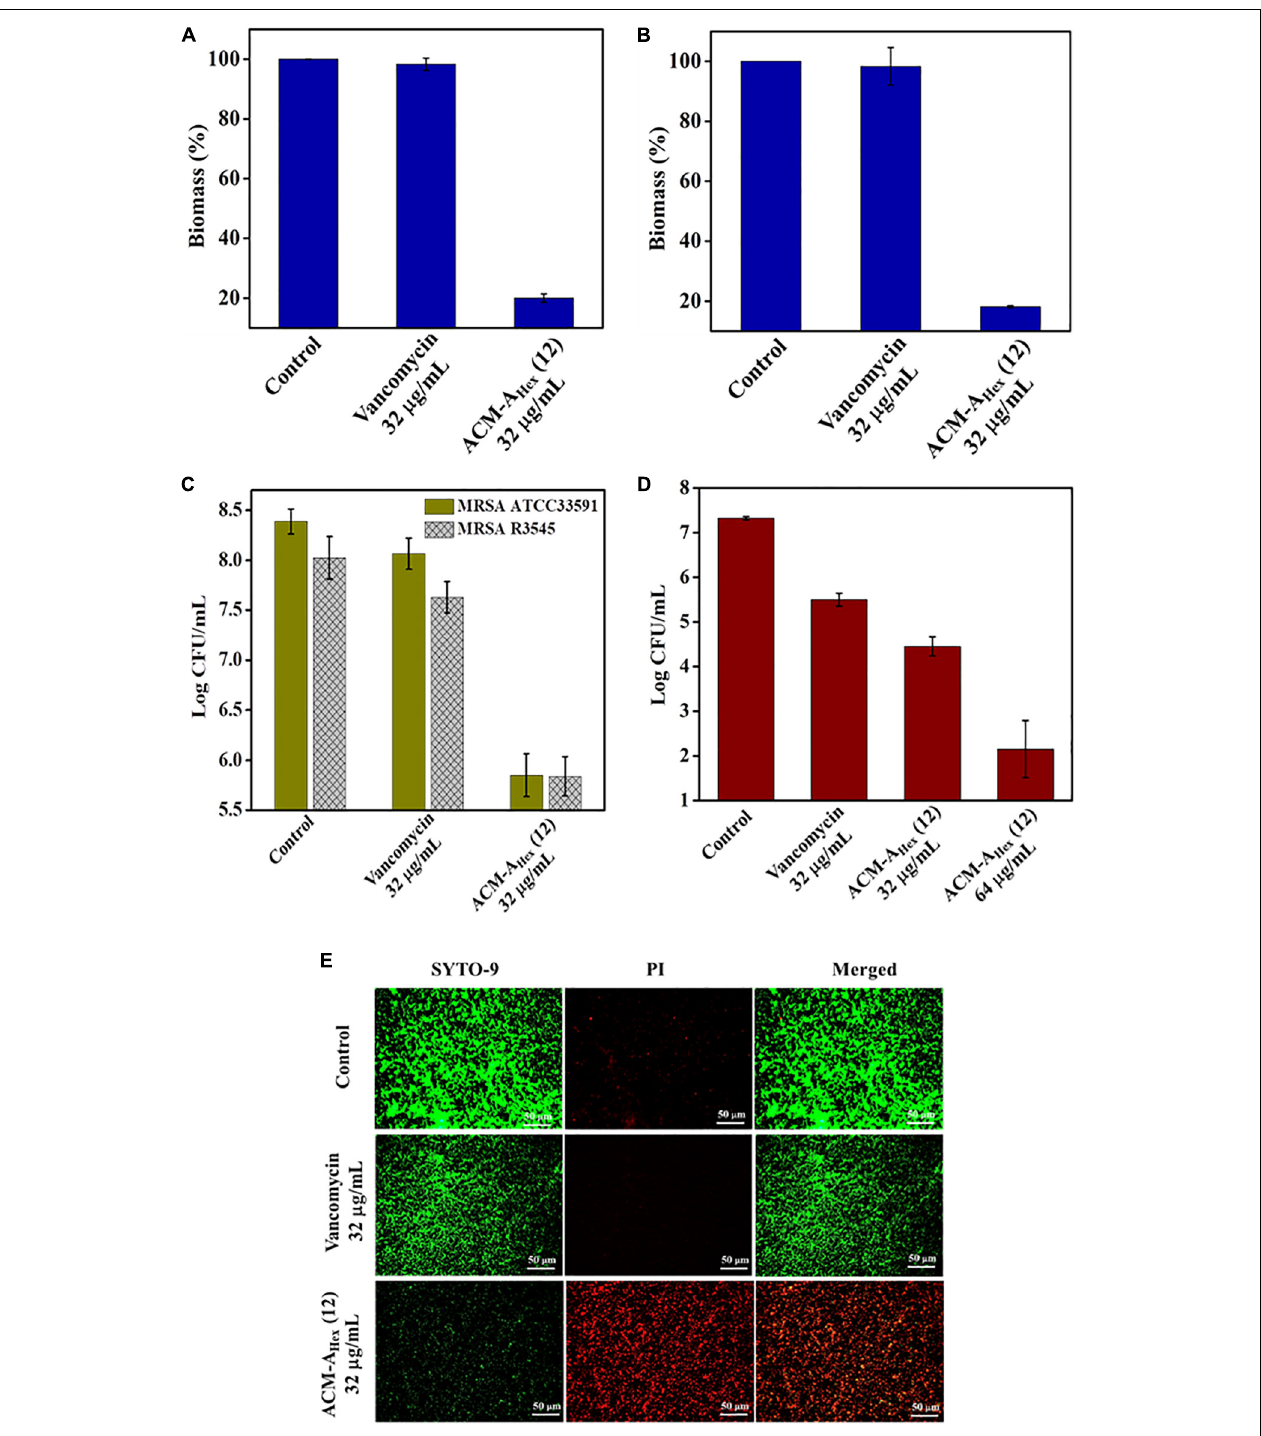
FIGURE 5 | Anti-biofilm activity of ACM-A Hex ( 12 ). Quantification of biofilm biomass after crystal violet straining for (A) MRSA ATCC33591 ( p = 0.0046, one-way ANOVA) and (B) MRSA R3545 ( p = 0.0007, one-way ANOVA). Quantification of bacterial cells after treatment for (C) MRSA ATCC33591 ( p = 0.014, one-way ANOVA) and MRSA R3545 ( p = 0.0198, one way ANOVA). (D) Activity against dispersed cells originated from MRSA ATCC33591 biofilm ( p = 0.0114, one-way ANOVA). Herein, each value represents average of three different experimental values and error bar indicates standard deviation. (E) Fluorescence microscopy images of MRSA ATCC33591 biofilm by SYTO-9 and PI staining. Scale bar is 50 µ m.